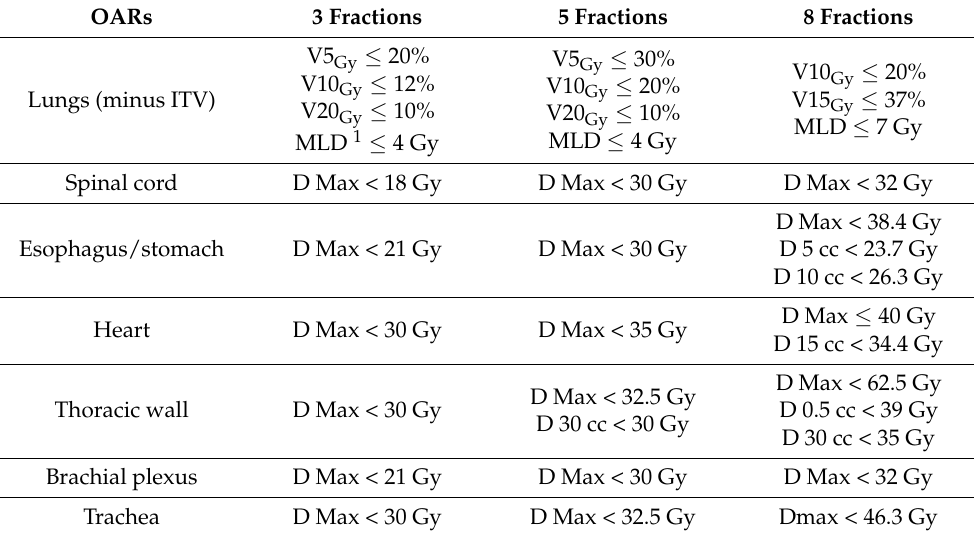
Table 2. Organs at risk’s dose constraints for lung lesions: 1 Mean Lung